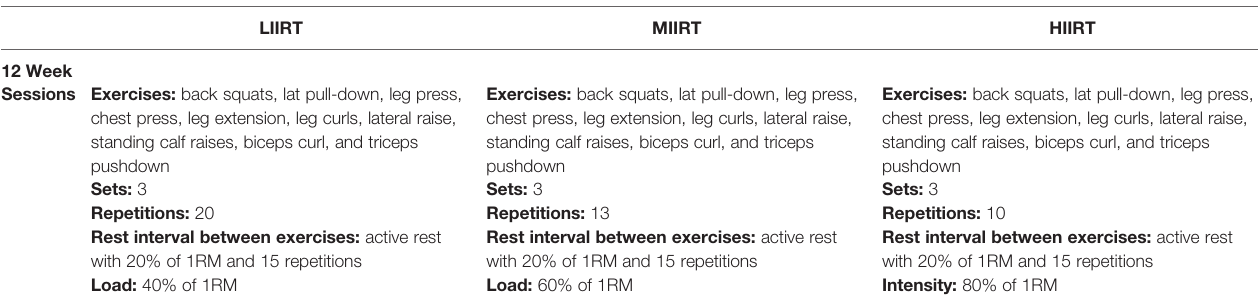
Exercises: back squats, lat pull-down, leg press, chest press, leg extension, leg curls, lateral raise, standing calf raises, biceps curl, and triceps pushdown Sets: 3 Repetitions: 10 Rest interval between exercises: active rest with 20% of 1RM and 15 repetitions Intensity: 80% of